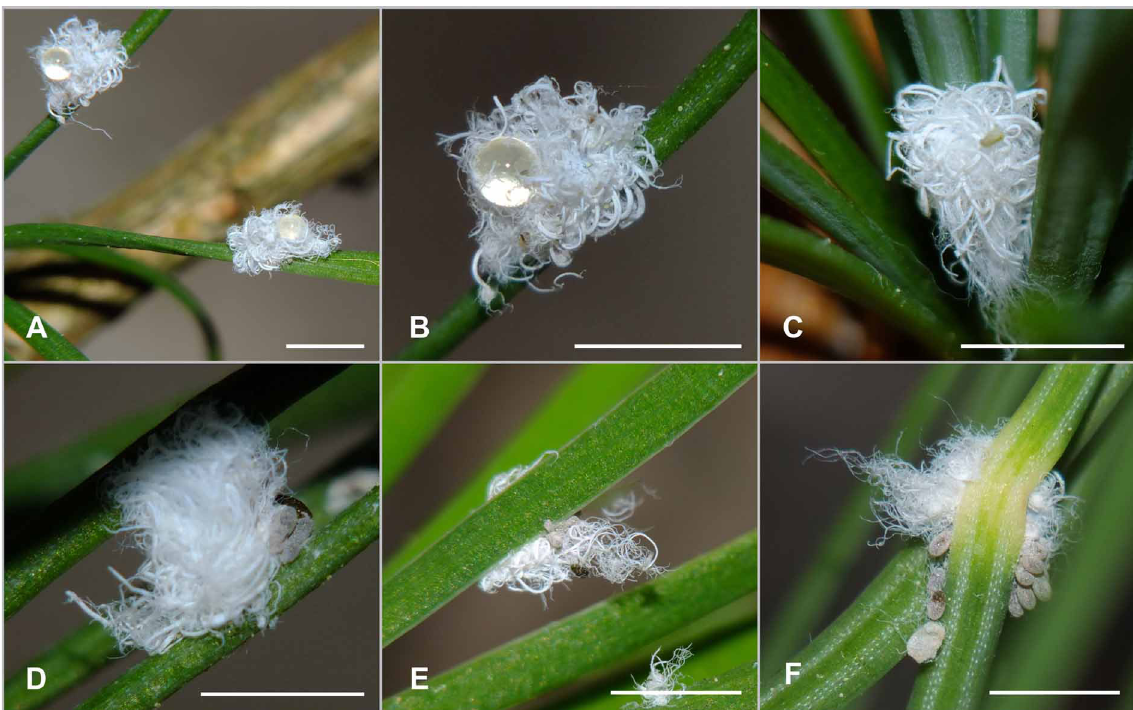
Fig. 60. Adelges (Adelges) laricis Vallot, 1836. Adult apterous progredientes with eggs and honeydew droplets on Larix sibirica . ( A–D ) and Larix kaempferi ( E–F ). Scale bars: about 2.5 mm.